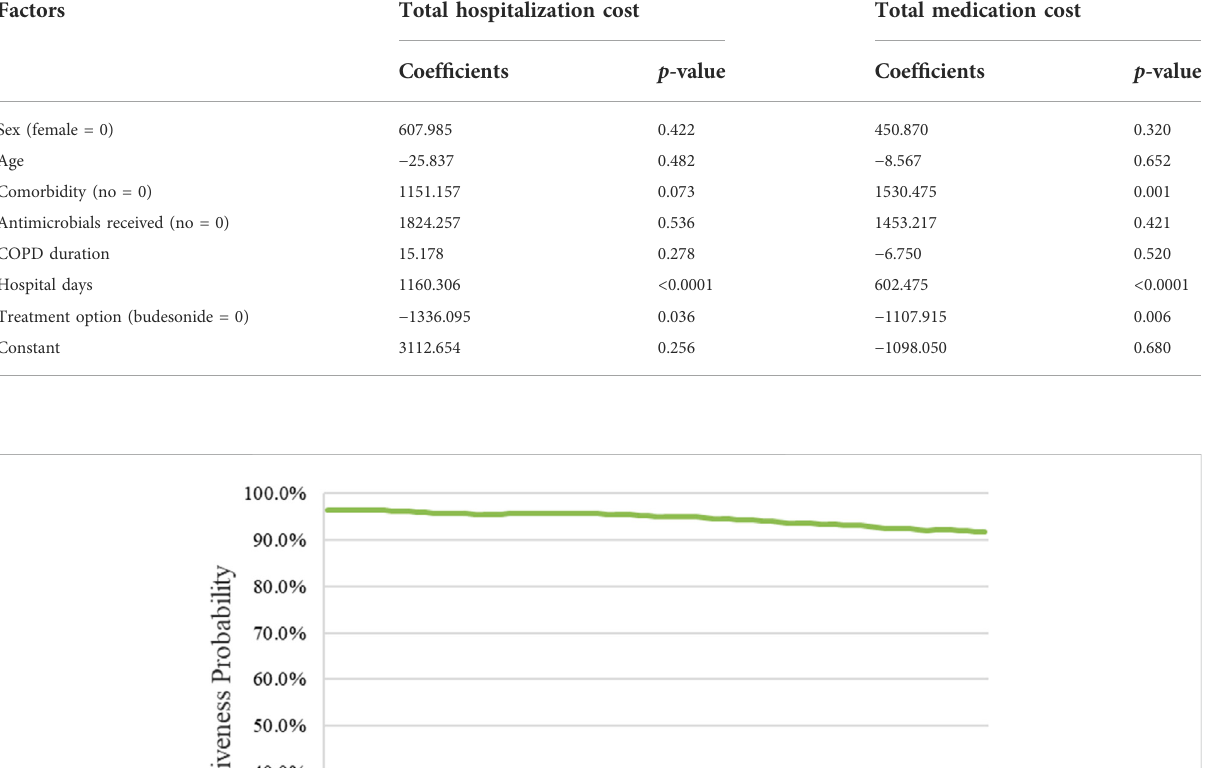
TABLE 7 Multiple linear regression model for hospitalization costs.